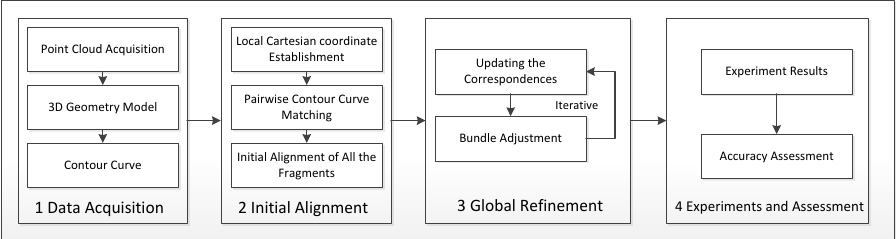
Figure 1. Flow Chart of Reassembling Thin Fragments Found at Archaeology